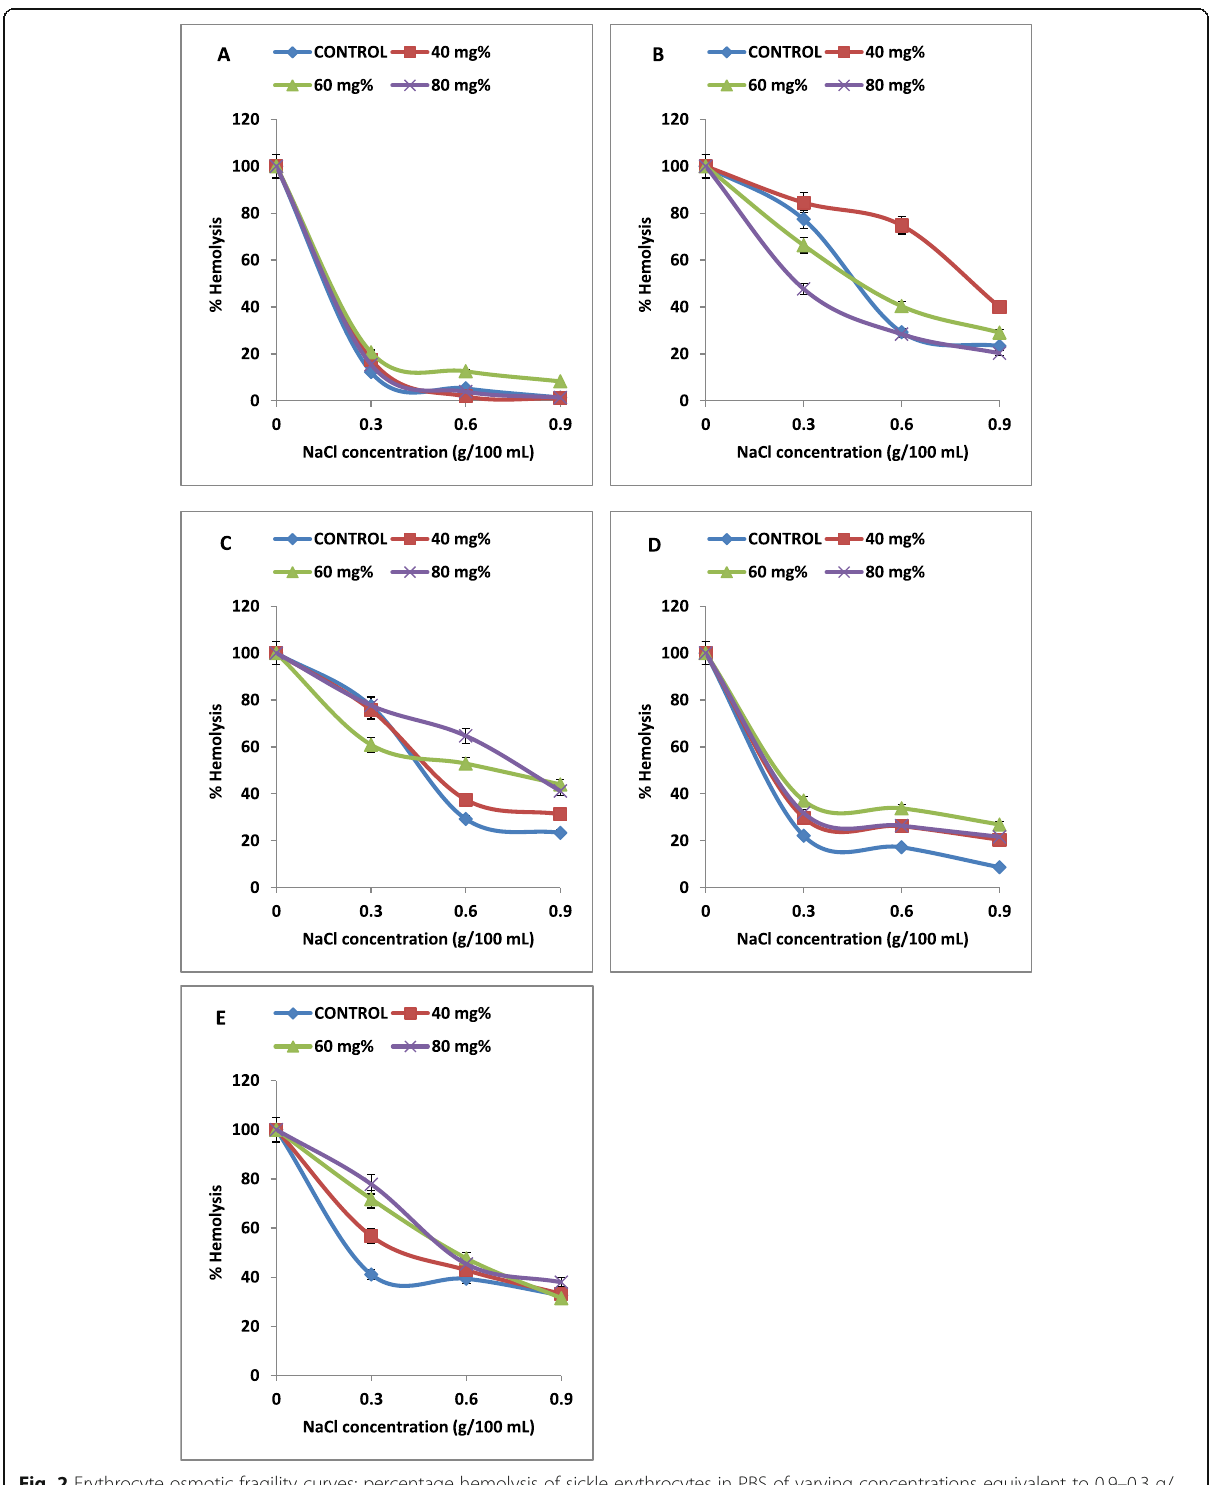
Fig. 2 Erythrocyte osmotic fragility curves: percentage hemolysis of sickle erythrocytes in PBS of varying concentrations equivalent to 0.9 – 0.3 g/ 100 mL NaCI in the presence of fractionated leaf extracts of P . guajava . a Petroleum ether. b n -hexane. c Chloroform. d Ethylacetate. e Residual